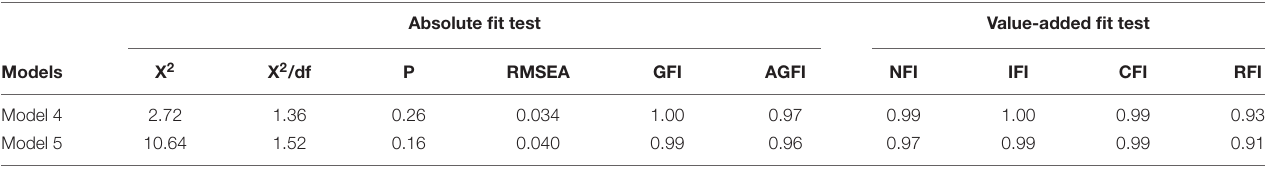
TABLE 4 | Statistical table of the degree of fit for model